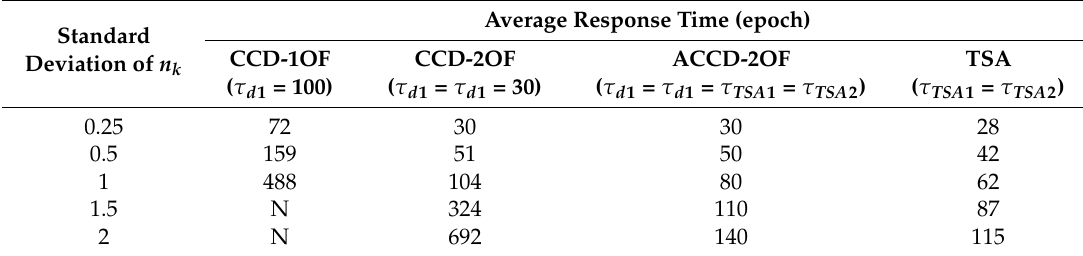
Table 1. Comparing the response time to anomaly of four methods in different standard deviations of noise. ACCD, advanced CCD.